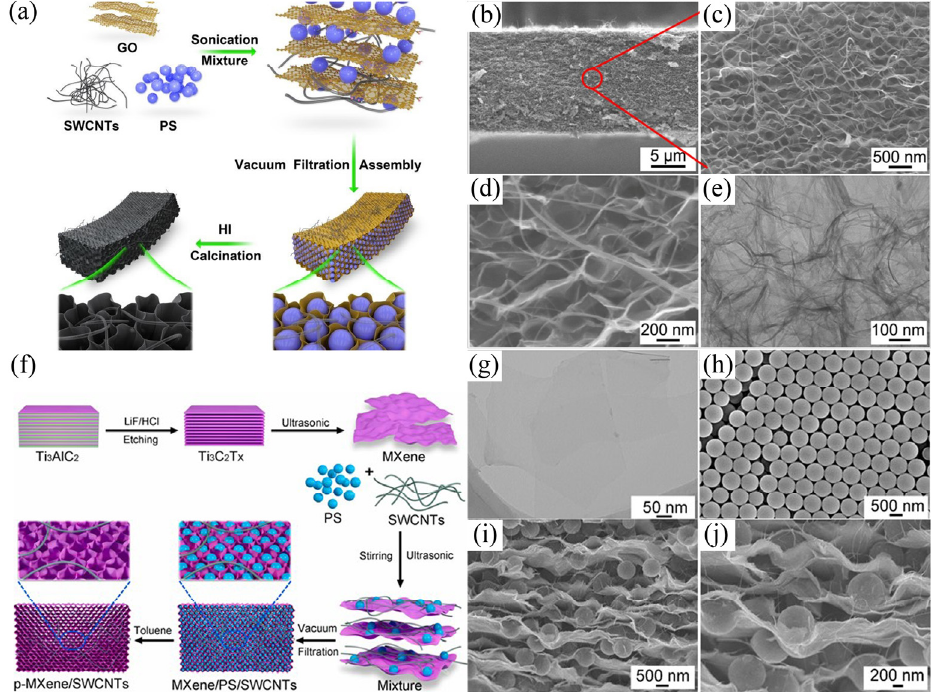
Figure 5. ( a ) The preparation schematic of rGO/SWCNTs film; ( b – d ) SEM images (cross-section) of the film; ( e ) TEM image of the film. Reprinted with permission from Reference [105]. Copyright 2022 American Chemical Society. ( f ) The preparation schematic of MXene/SWCNTs film; ( g ) TEM image of Mxene; ( h ) SEM image of PS microspheres (0.6) (0.6 means the diameter of PS spheres with 600 nm); ( i , j ) SEM images (cross-section) of MXene/PS/SWCNTs (0.6) composites. Reprinted from Reference [106] with permission.